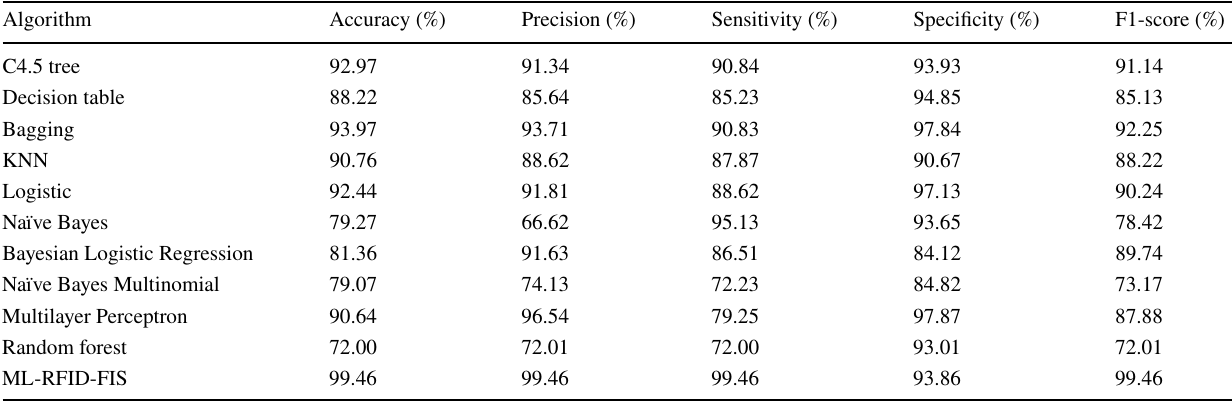
Table 15 Overall performance comparison of the ML-RFID-FIS Algorithm